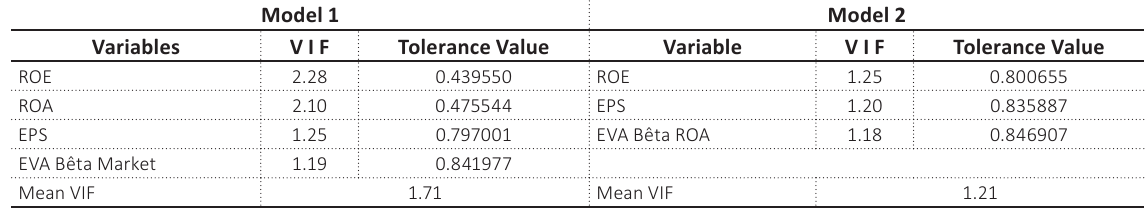
Table 4. Multicollinearity